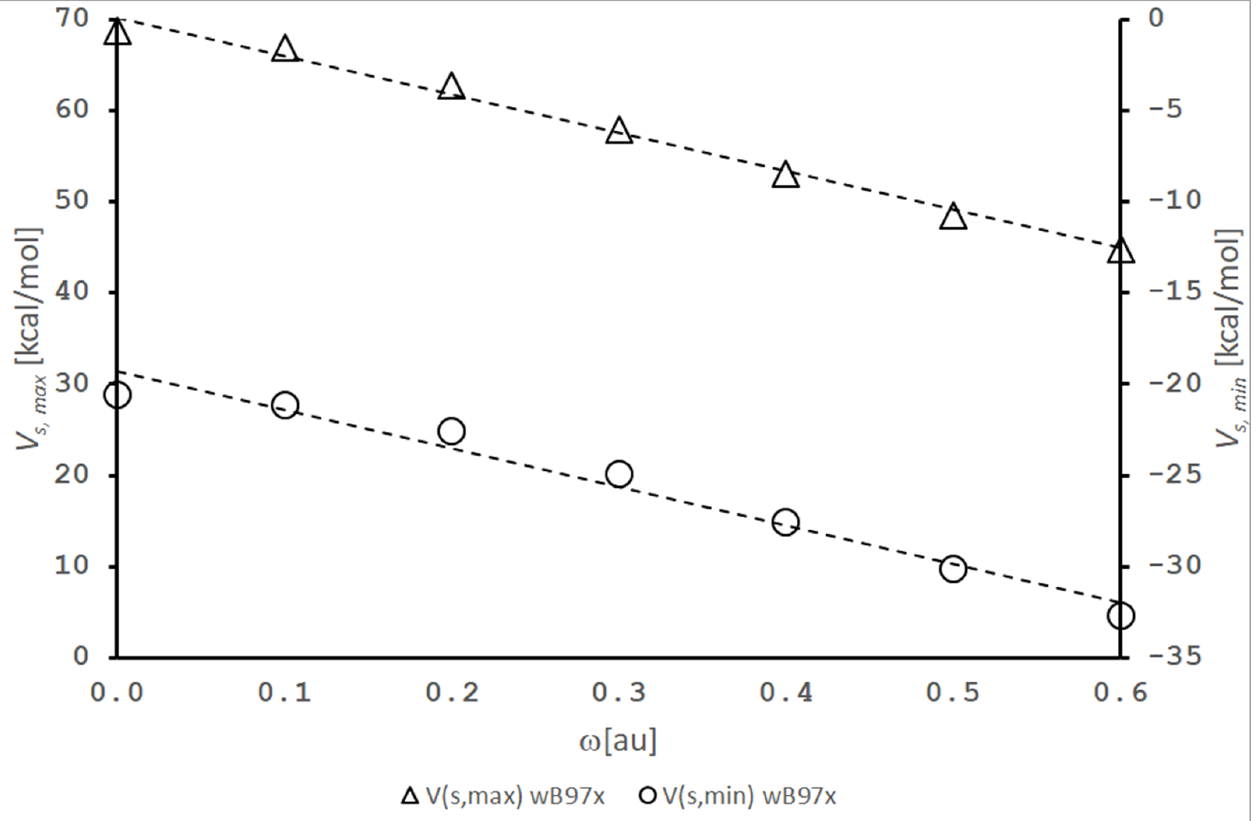
Figure 3. The V s,max (the maximum values of MEP) and V s,min (the minimum values of MEP) as a function of the strength confinement ( ω ) for the HF molecule. R 2 is equal to 0.9912 and 0.9712 for V s,max and V s,min , respectively.